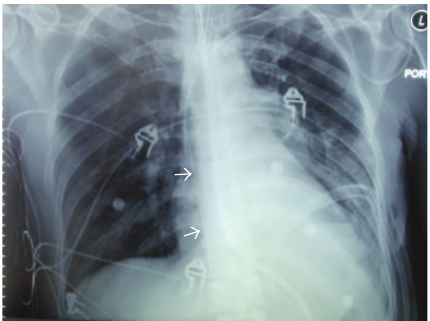
Figure 3: Pelvic X-ray showing the guidewire extending into the femoral vein in the right thigh.